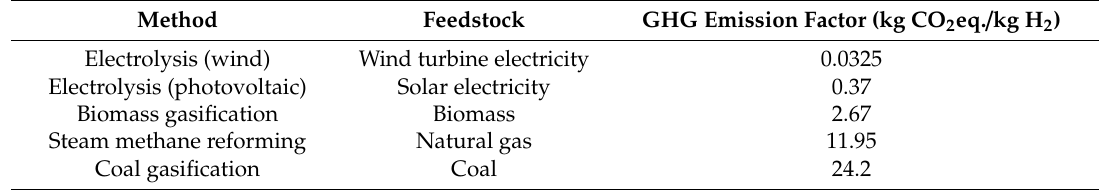
Table 5. Emission factor for hydrogen production from various sources